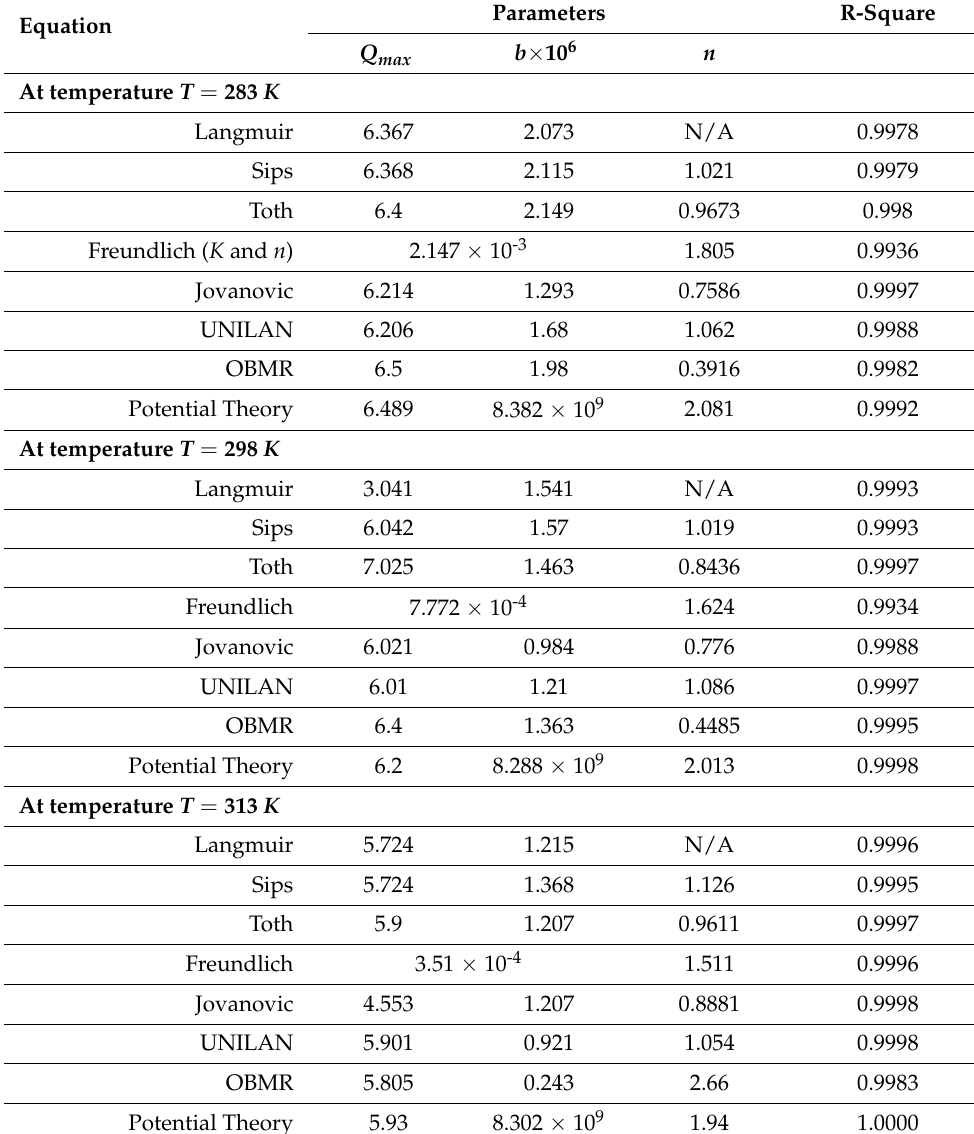
Table A3. Coefficients of the model equations obtained by nonlinear regression of experimental data for the methane gas at different